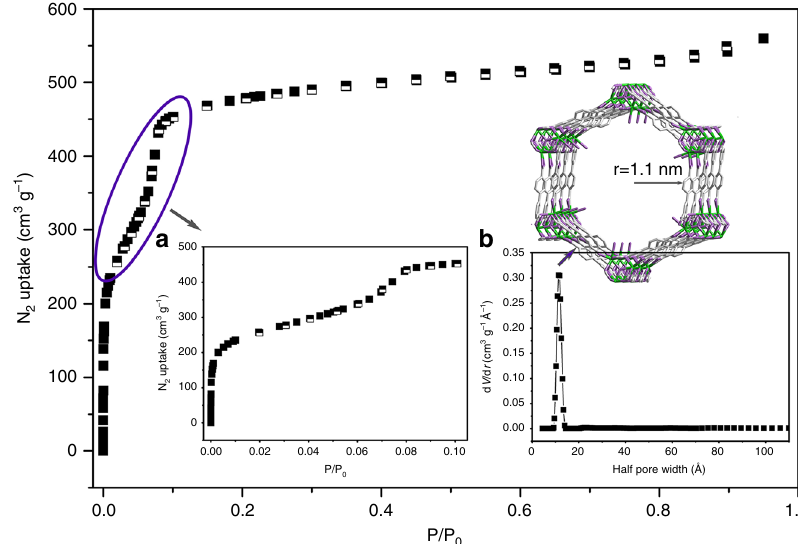
Fig. 2 The N 2 adsorption isotherm for SCU-8 at 77 K. a the detail view P/P 0 between 0 – 0.1; b DFT pores size distribution of framework and crystallizes in the hexagonal space group P 6 3 / m .